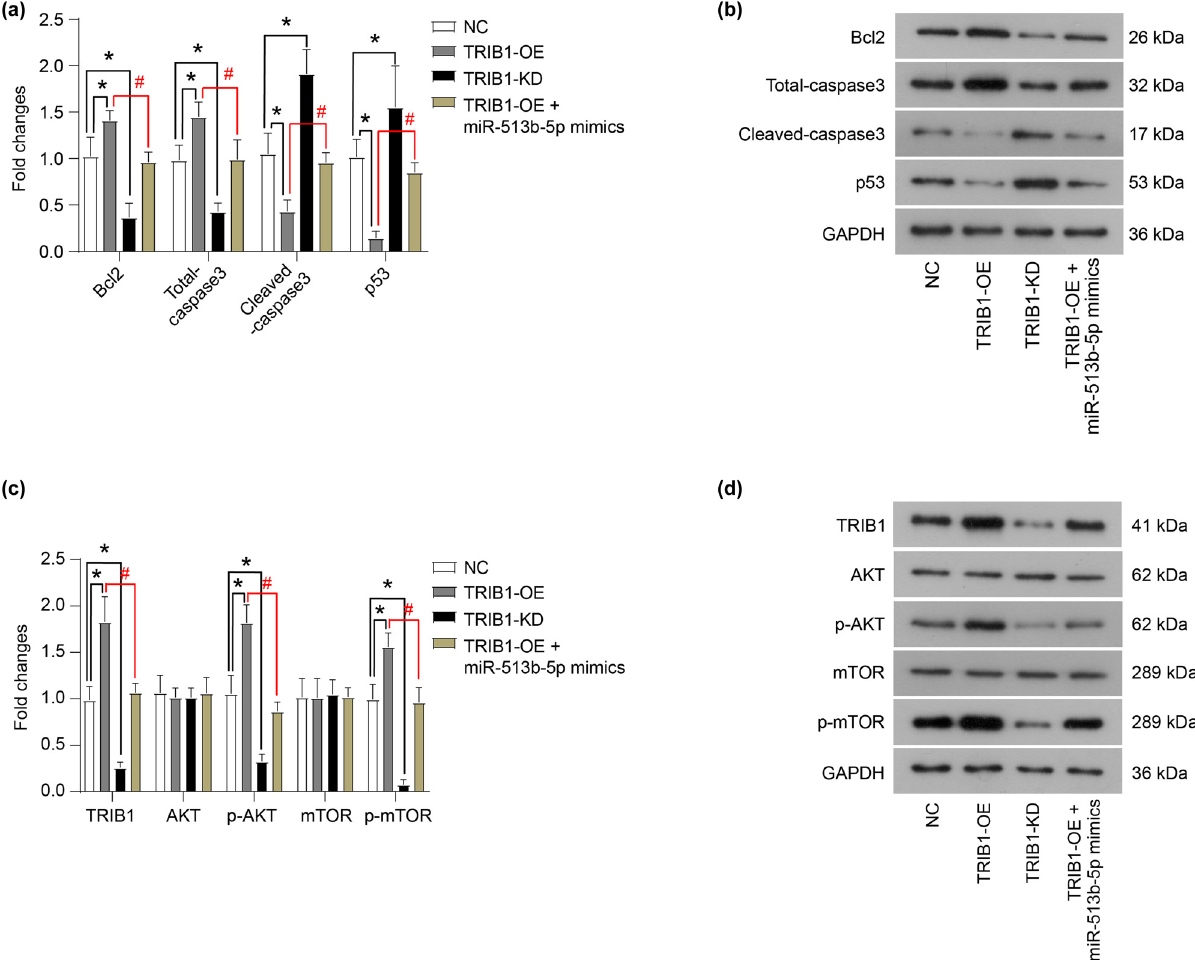
Figure 5: TRIB1 promotes the activation of the AKT/mTOR signaling pathway. ( a and b ) The protein expression of key proteins related to apoptosis was measured using western blot. ( c and d ) The protein expression of key proteins in the AKT/mTOR signaling pathway was measured using western blot. The di ff erences were evaluated using the Mann – Whitney U - test for pair - wise comparisons. * P < 0.05, compared to NC; # P < 0.05, compared to TRIB1 - OE. Each group of ( b and d ) includes three samples. All experiments were repeated three times independently, and the individual experiments were performed 1 week